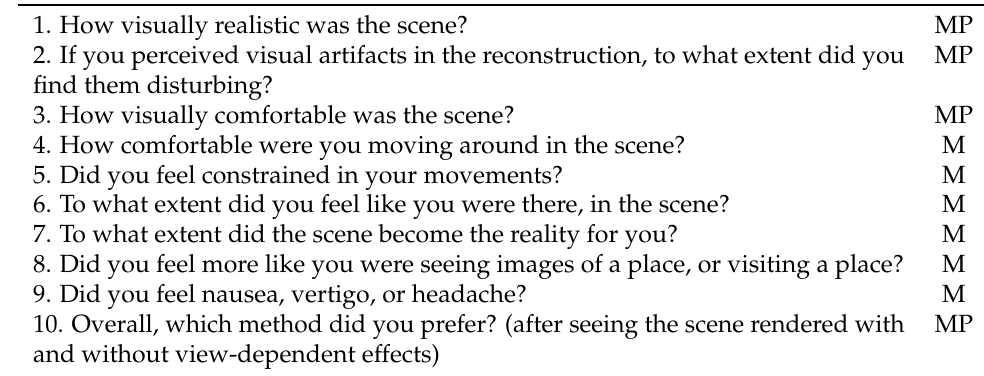
Table 1. Study questionnaire, with “MP” if asked in both the “Museum” and “Pyrite” scenes, and “M” if only asked in the former.